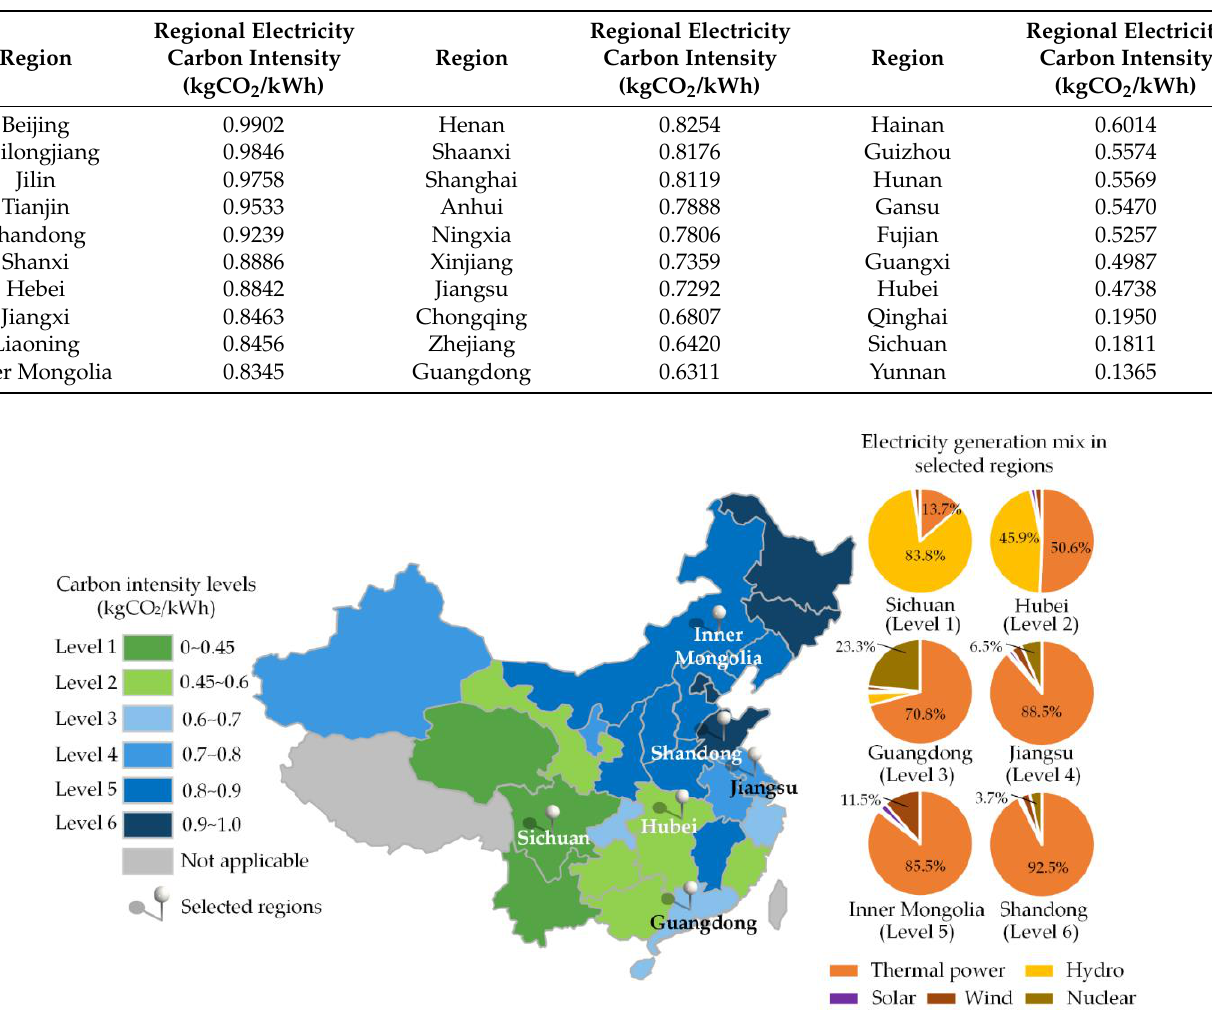
Table 6. Comprehensive comparison of life cycle CO 2 emissions between a BEV and ICEV in differ- ent regions of China.